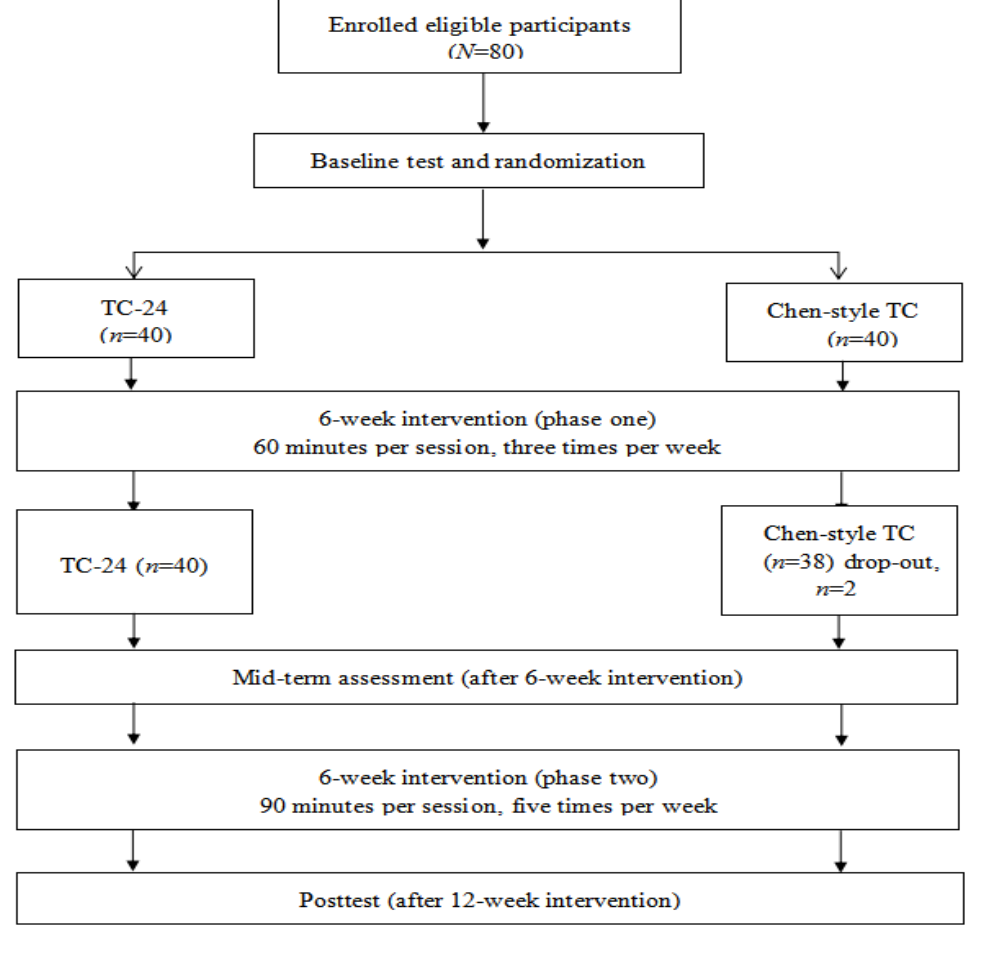
Figure 1. Flowchart of the study. TC = Tai Chi; TC-24 = 24-style Tai Chi.